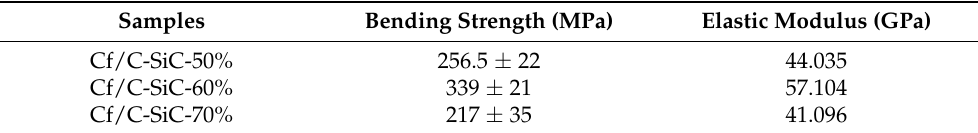
Table 4. Flexural strength of Cf/C-SiC composites with different binary binder content.